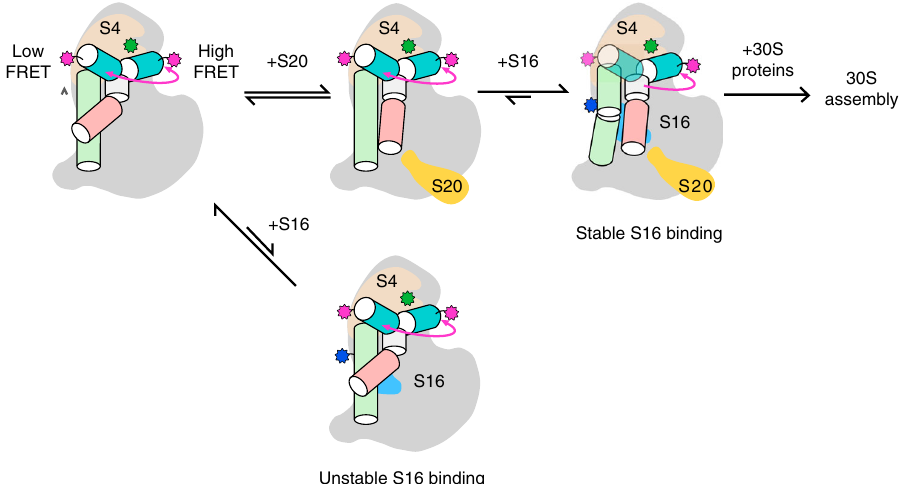
Fig. 6 Protein-dependent switch in RNA dynamics promotes the hierarchical assembly of multi-protein complexes. Heterogeneously fl uctuating encounter complexes between protein S4 ( tan ) and the 16S 5 ′ domain RNA ( gray ) transition to a slow equilibrium between a non-native low FRET conformation, in which 16S h3 fl ips away from S4, and a native high FRET conformation in which h3 docks against S4 ( pink arrow ). Binding of protein S20 does not alter the h3 equilibrium, but increases the probability of stable S16 binding by switching the conformation of h15 and neighboring helices (Supplementary Fig. 7). In the absence of S20, S16 dissociates from the RNA within a few seconds. Although h3 continues to fl uctuate between low and high FRET conformations in S4 – S20 – S16 complexes, S16 binding progressively stabilizes the docked h3 complex that is competent to bind protein S12 during late steps of